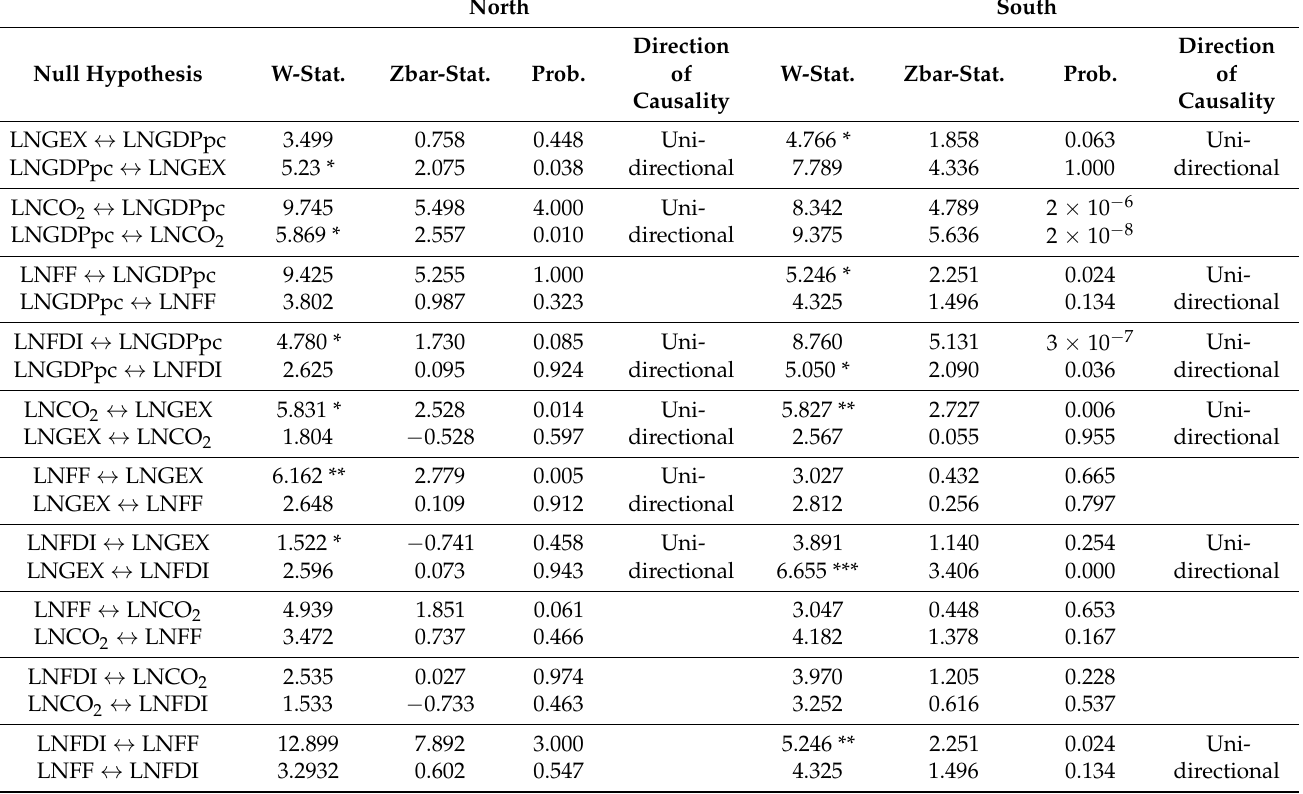
Table 8. Granger